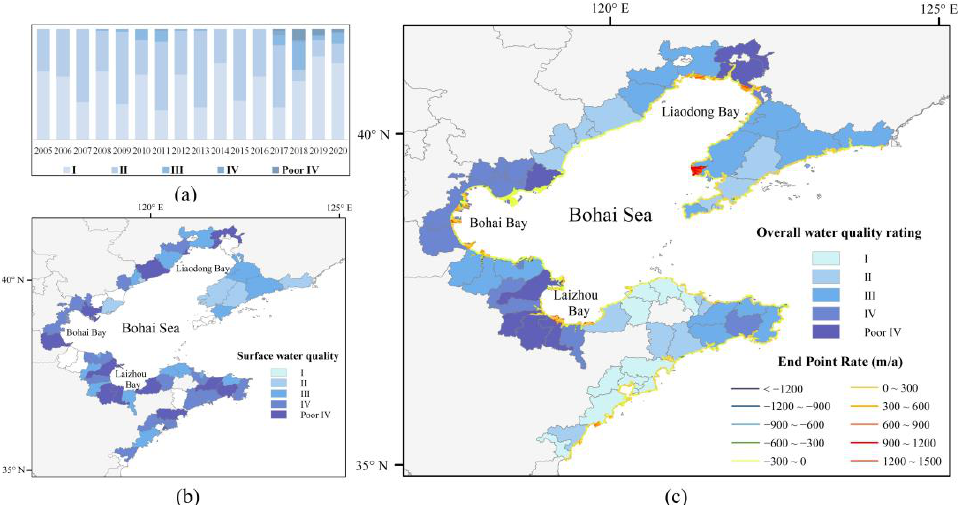
Figure 6. Environmental effects of long-time-series changes in the coastline: ( a ) overall water quality changes; ( b ) surface water quality classes in coastal districts and counties; ( c ) coupling coastline migration rates with changes in water quality.